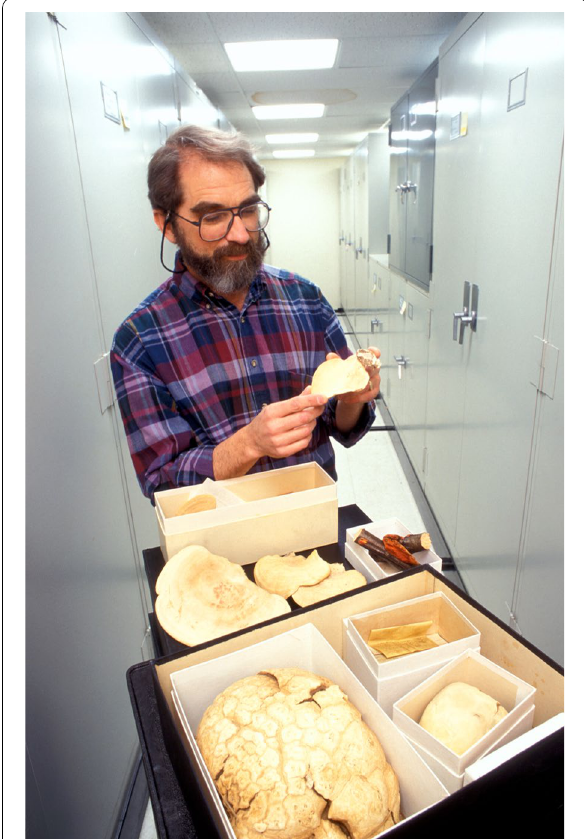
Fig. 15 David F. Farr examining specimens in the US National